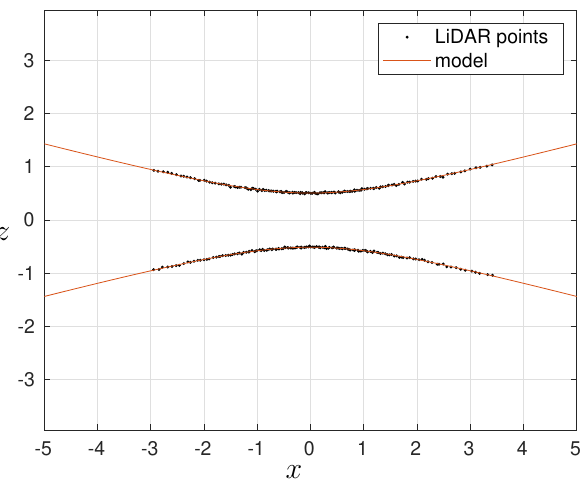
Figure 5. A hyperbola as a model representing scan